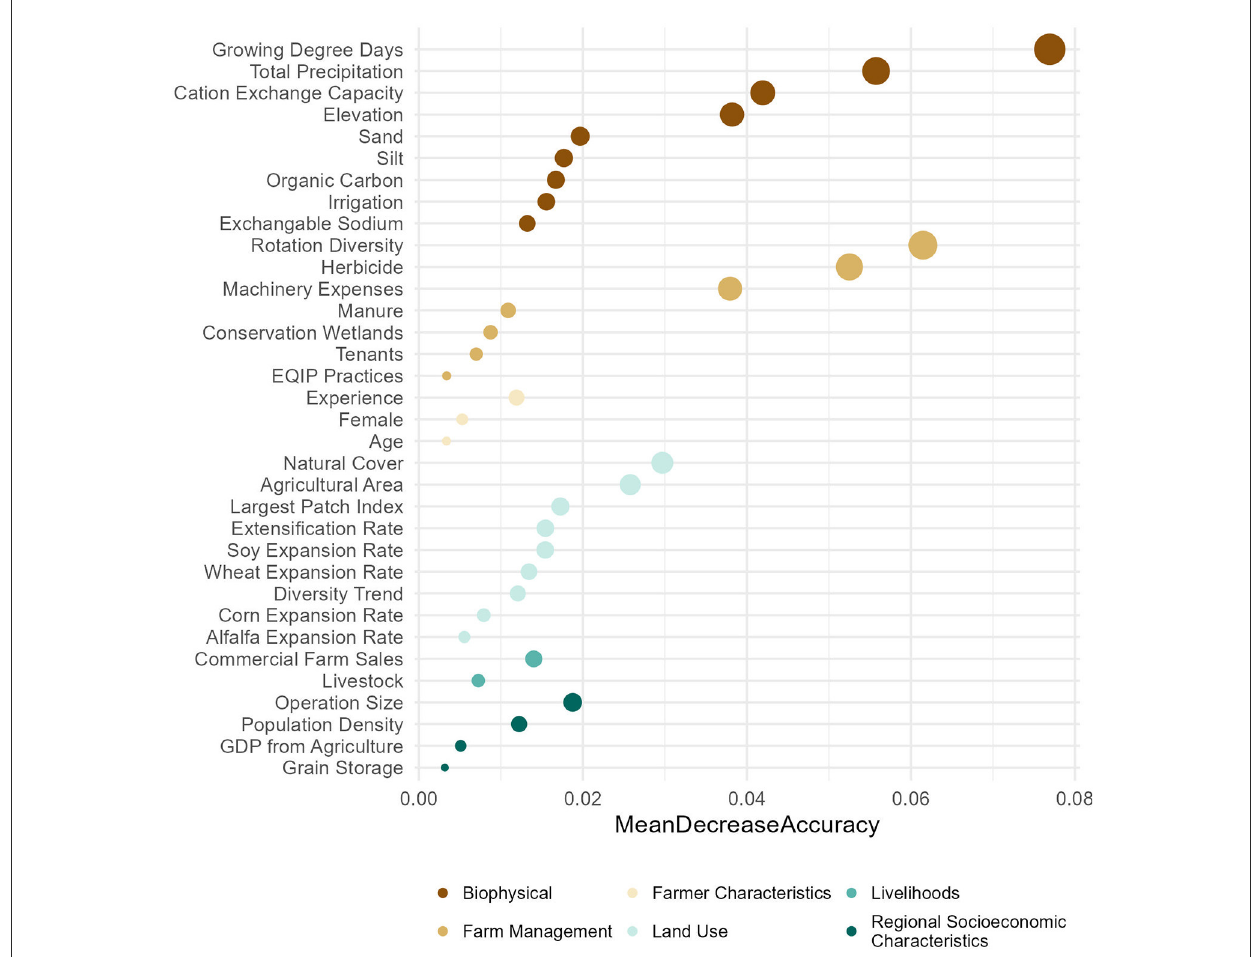
FIGURE3 Variable importance for random forests classification analysis using a 70% random sample of all counties ( n =